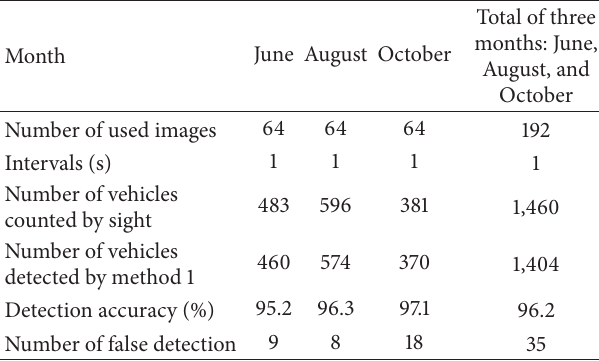
Table 1: Vehicle detection results using three video